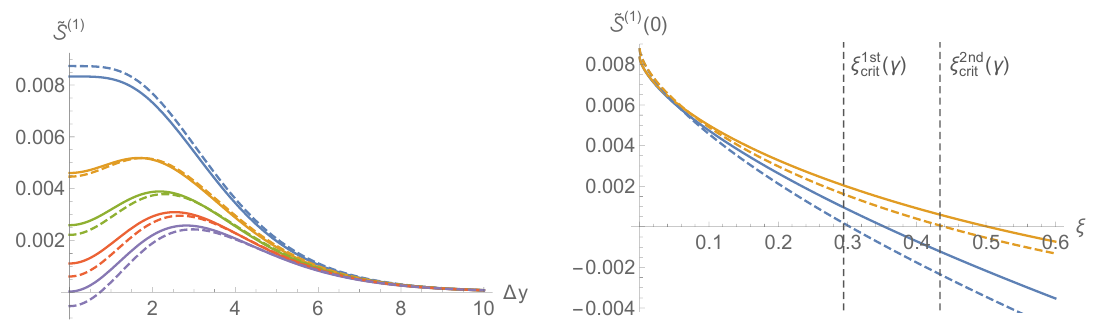
Figure 3 . Left: plots for ~ S (1) (cid:17) S (1) (cid:28) 4 = 3 =w 4 (cid:1) x 4 for various values of (cid:24) = (cid:28) (cid:0) 1 w (cid:0) 3 = 2 = 3 0 0 f 0 ; 0 : 12 ; 0 : 25 ; 0 : 38 ; 0 : 5 g depicted in blue, orange, green, red and purple, respectively. Solid lines cor- respond to (cid:13) = 0 (Einstein gravity) while the dashed lines correspond to (cid:13) = 10 (cid:0) 3 ( (cid:11) 0 -corrections), in both cases for second-order hydrodynamics. Right: plots for ~ S (1) (0) for (cid:12)rst- and second-order hydrodynamics, depicted in blue and orange, respectively. Solid lines correspond to (cid:13) = 0 while dashed lines correspond to (cid:13) = 10 (cid:0) 3 . The dashed vertical lines correspond to the critical times at each order in hydrodynamics, including the leading (cid:11) 0 -corrections.